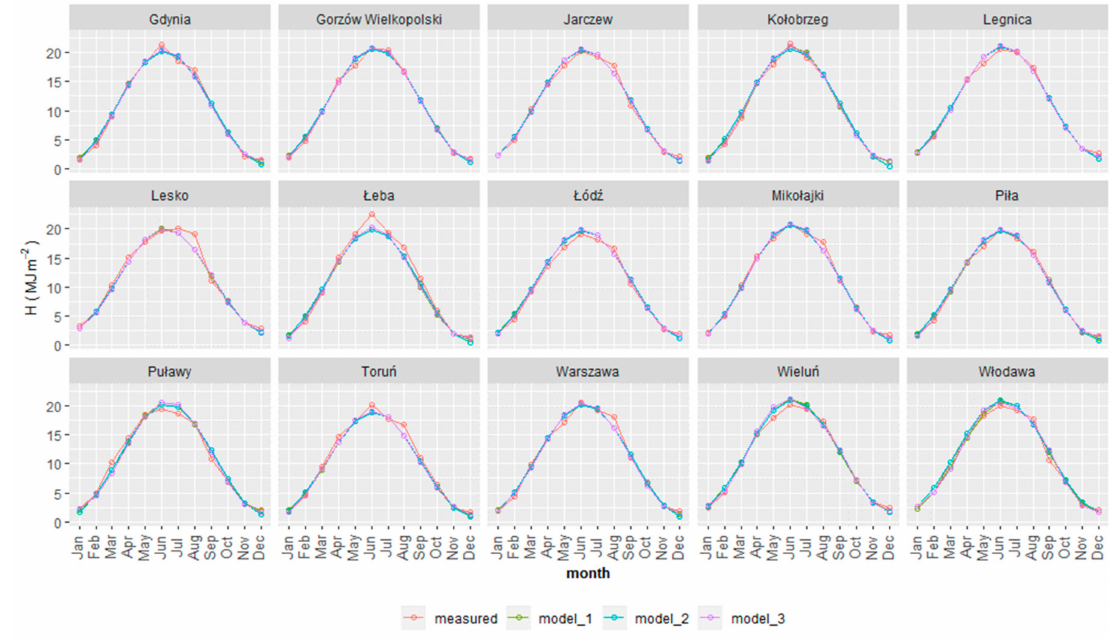
Figure 2. Comparison of the measured and calculated data for analyzed